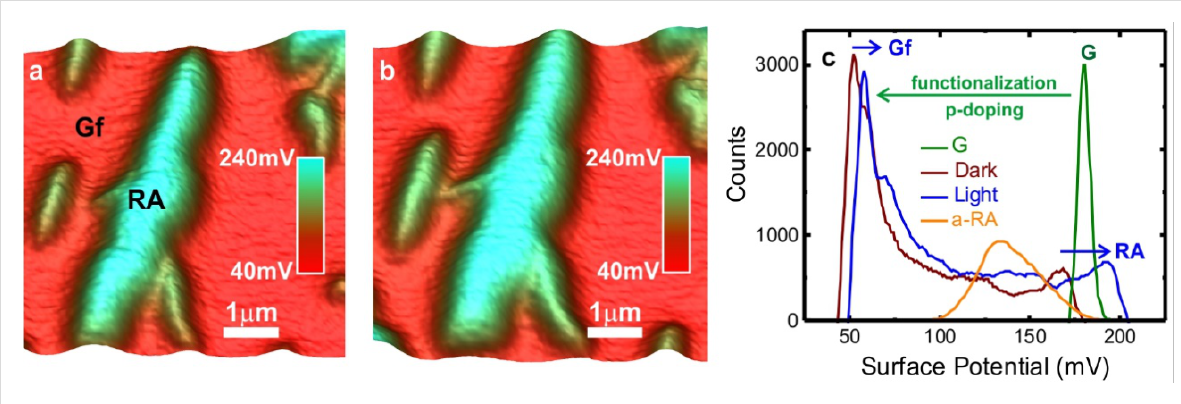
Figure 5: Photo-assisted SKPM characterization of the RA–graphene hybrid. Figures (a) and (b) show SKPM images of the same RA–graphene hybrid region in dark (a) or under illumination (b). In both images, red and green colors indicate functionalized graphene (graphite microplate surface, Gf) and retinoic acid covered (RA) regions, respectively. c) Plot of surface potential histograms of the SKPM images in (a) dark (brown line), (b) light (blue line). Surface potential histograms in dark from a pristine graphite microplate surface (G) – green line – and a thick amorphous retinoic acid layer (a-RA) – orange line – are also